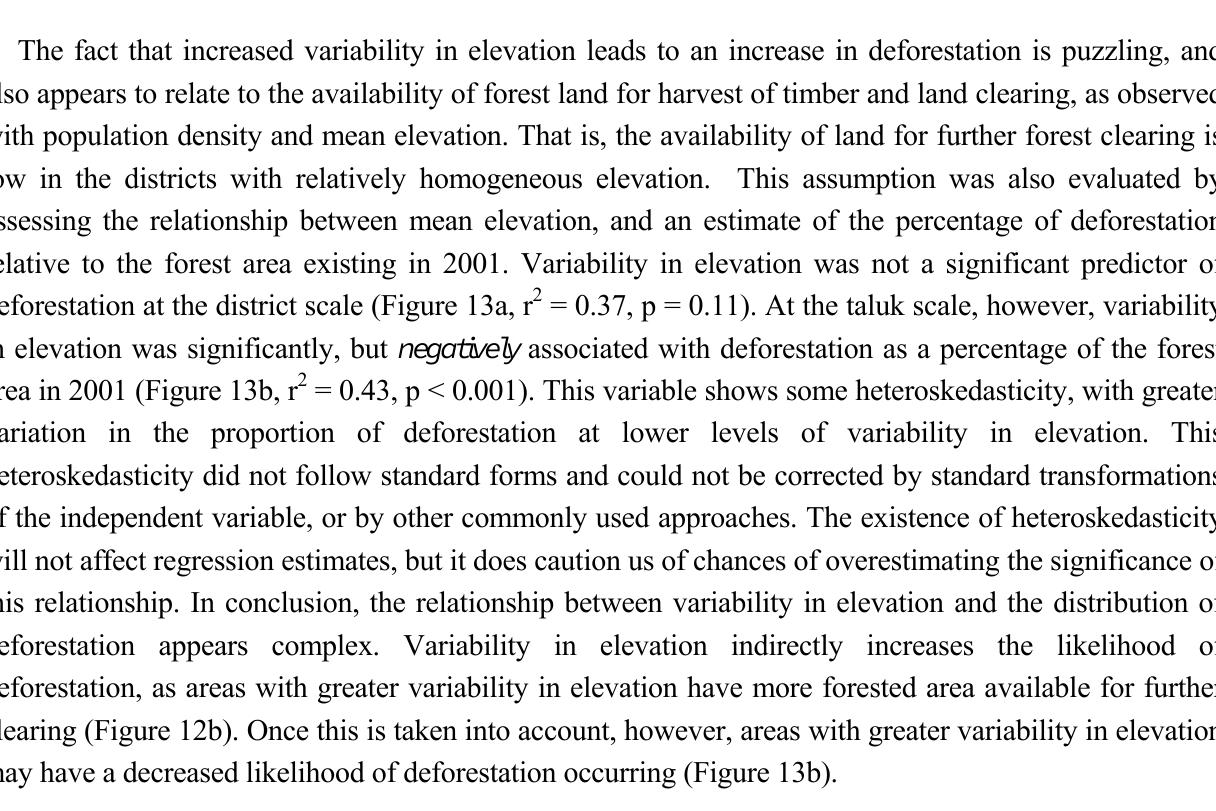
Figure 13a. Relationship between variation in elevation and the distribution of deforestation as a percentage of the forest area existing in 2001, for districts.